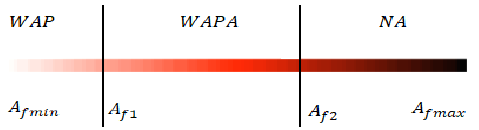
Figure 3. Ability to pay factors for WAP, WAPA, and NA.